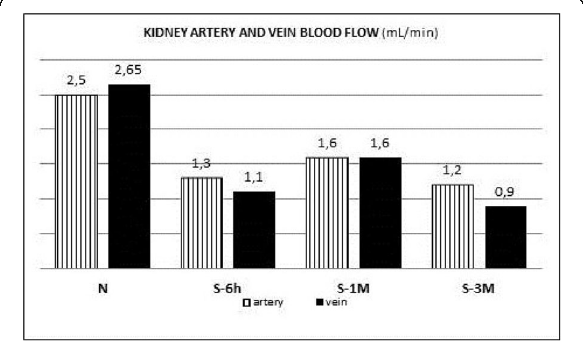
Fig. 1 (abstract 000984). Renal artery and vein blood flow following sepsis induction. S=sepsis, h=hours, M=month, N=name